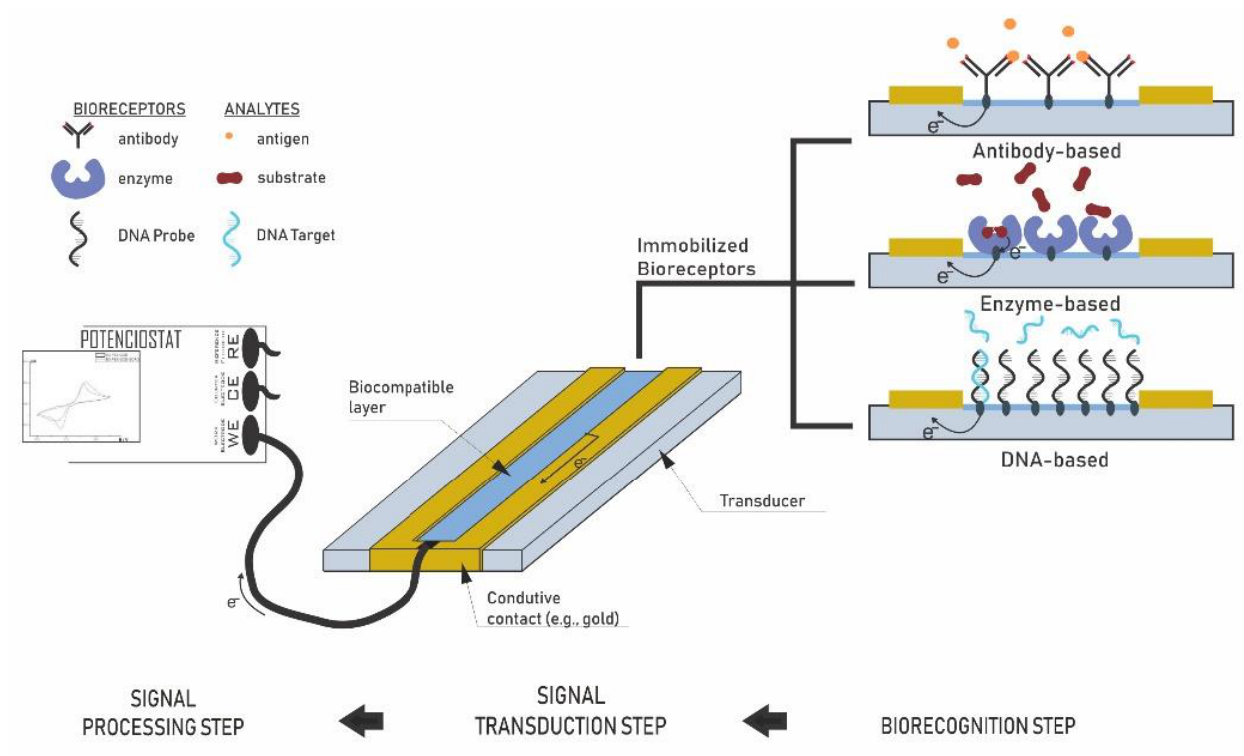
Figure 6. A typical design of antibody-, enzyme-, and DNA-based electrochemical biosensors, based on information from [46].